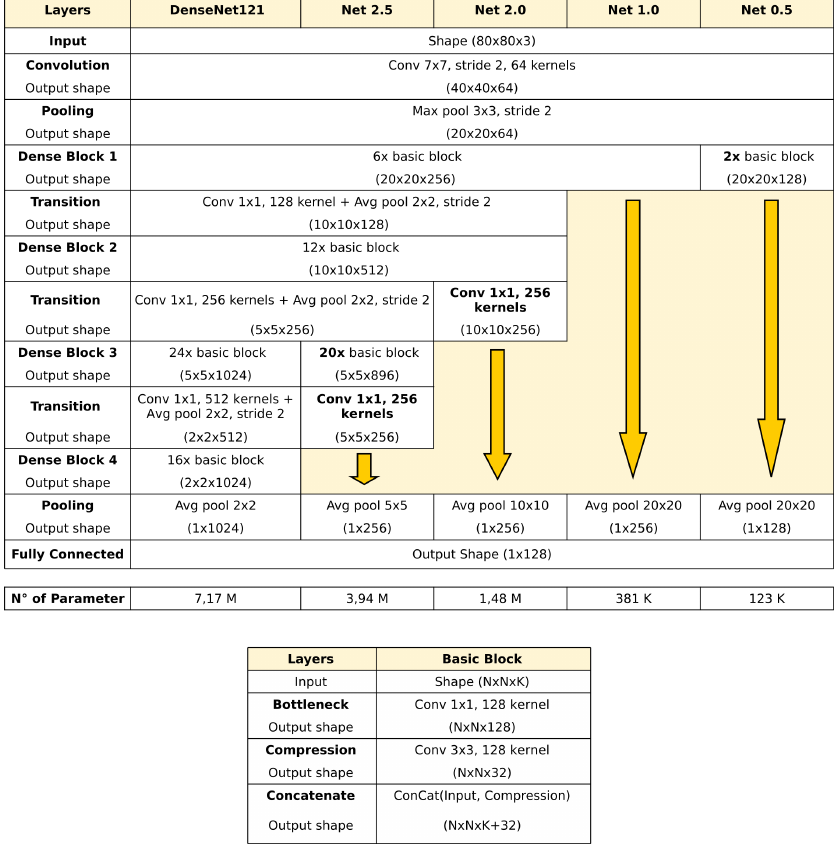
Figure 2. Schematic representation of the original Densenet121 model (first column) and our four different variants. In this work, Net 2.0 (3rd column) is chosen as our base recognition